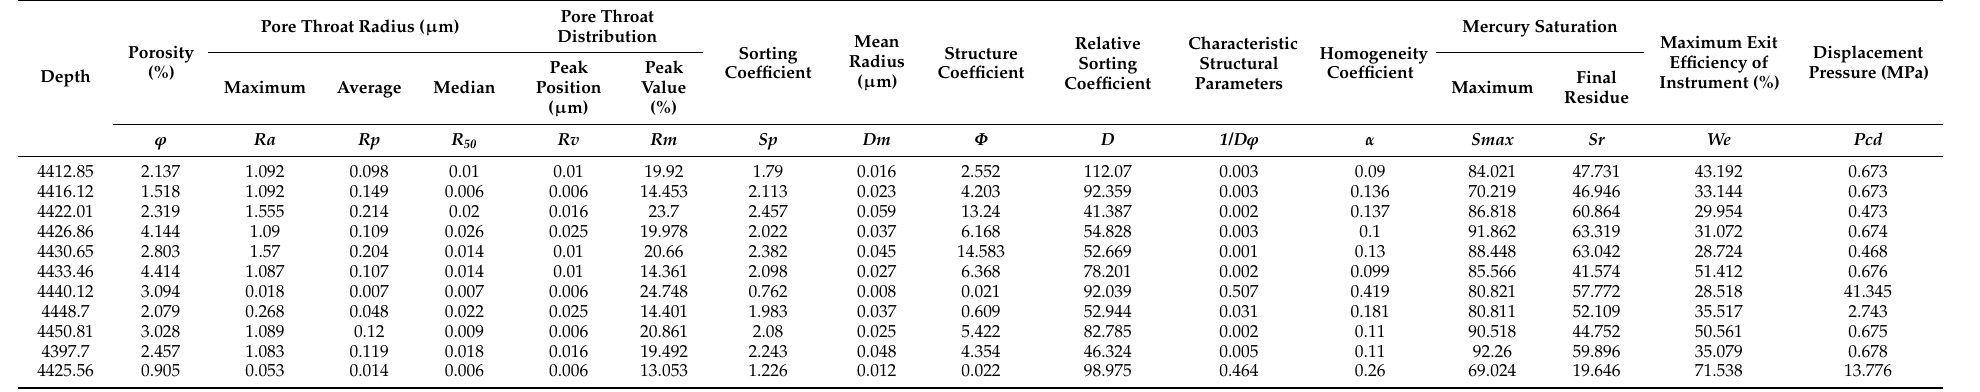
Table 2. Analysis table of eyelid and eyeball-shaped limestone pore throat structures in the first member of Maokou Formation of Xintan Well